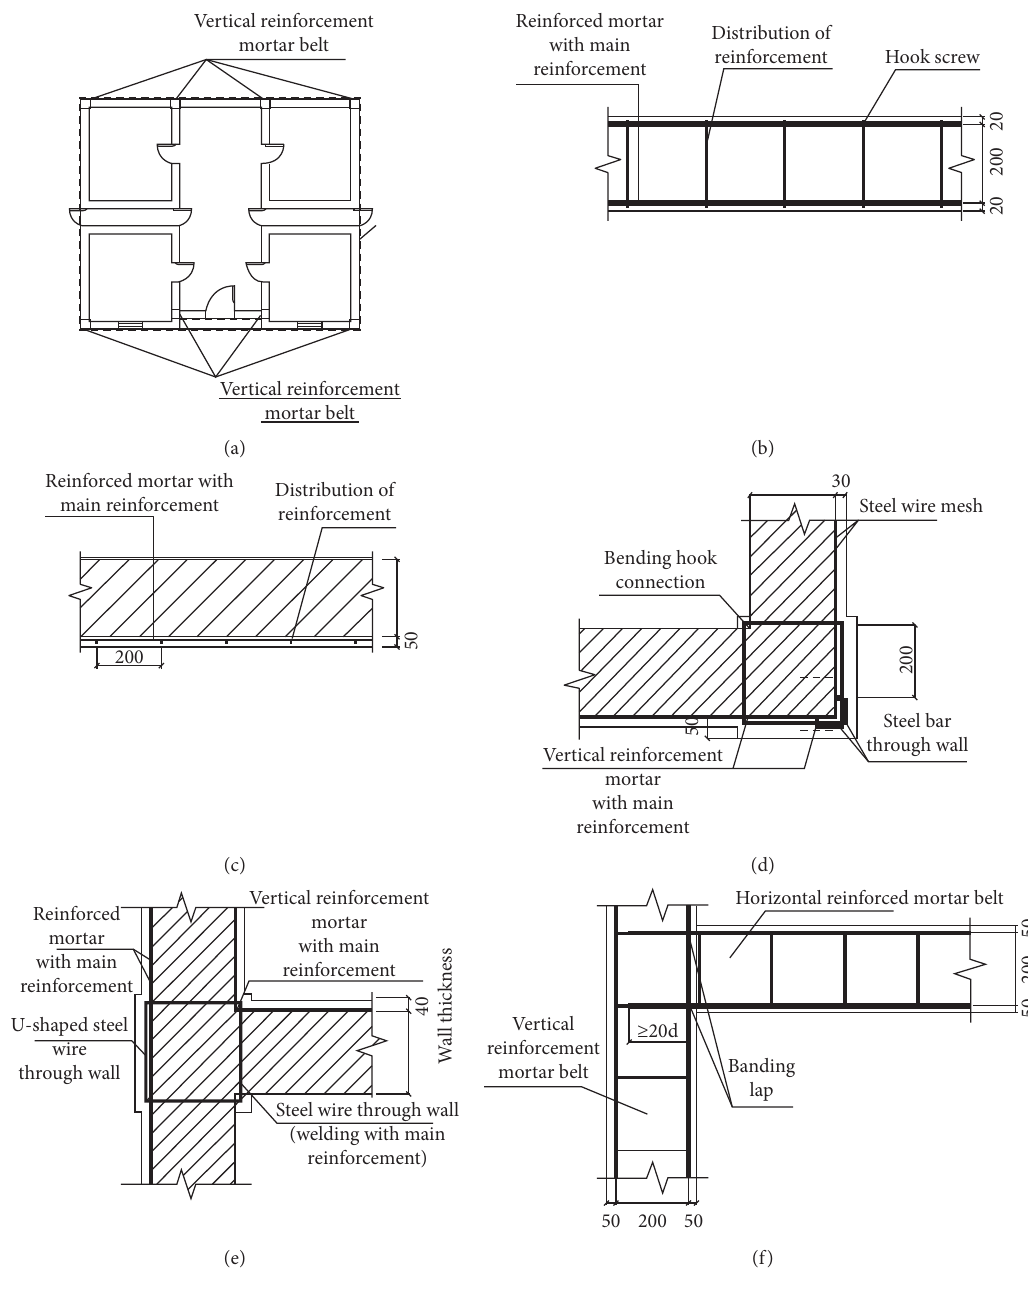
Figure 14: Schematic diagram of reinforced mortar belt. (a) Reinforced mortar belt layout drawing. (b) Brick masonry horizontal re- inforcement mortar belt reinforcement map. (c) Sectional view of horizontally reinforced mortar belt of brick masonry. (d) Reinforcement diagram of “L”-shaped vertical reinforcement mortar belt. (e) Reinforcement diagram of “T”-shaped vertical reinforcement mortar with reinforcement. (f) Node diagram at the junction of vertically reinforced mortar belt and horizontally reinforced mortar